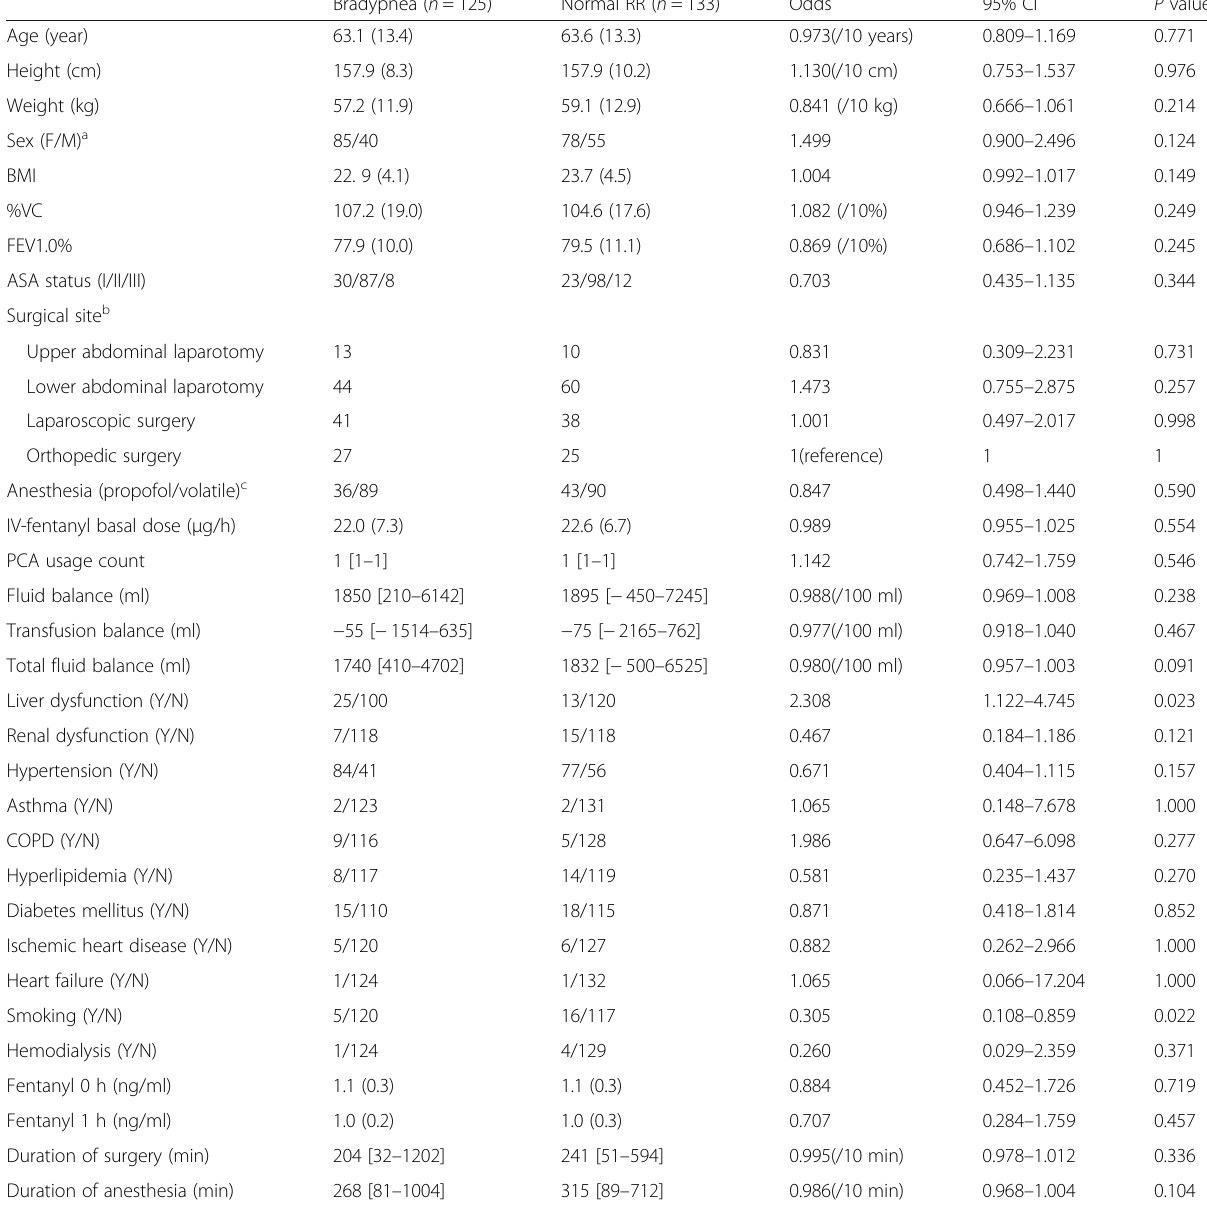
Table 1 Demographic and clinical characteristics and results of univariable logistic regression analyses for development of abnormal RRs Bradypnea ( n =